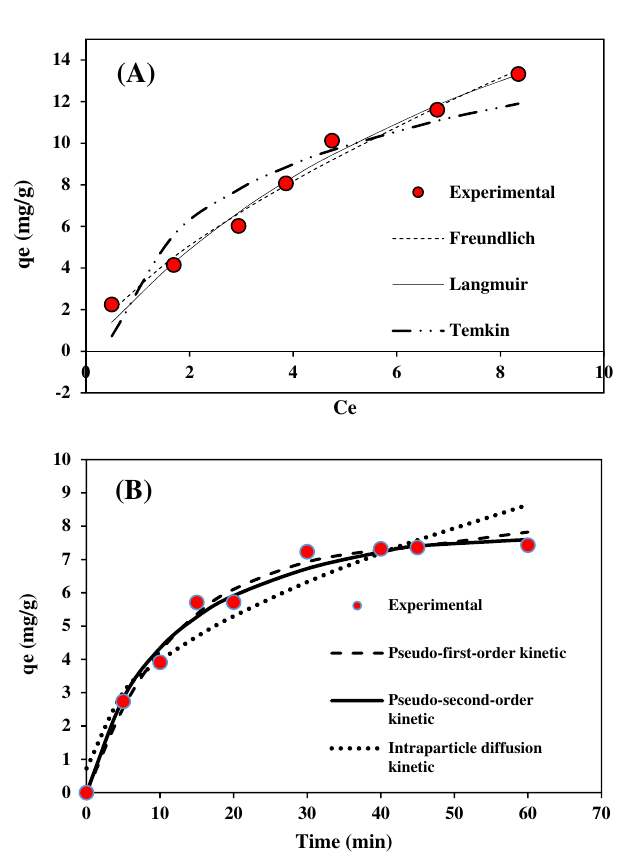
Figure 10. ( A ) AR18 non-linear isotherm model. ( B ) AR18 non-linear kinetic